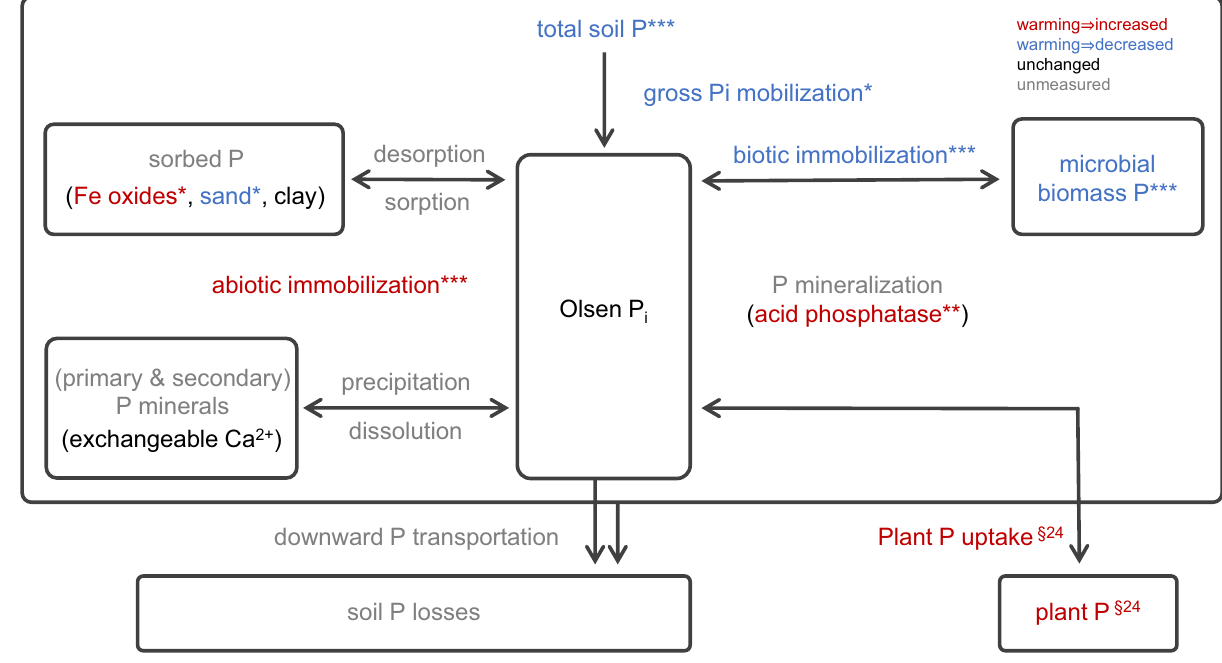
Fig.1|Schematicillustrationshowinglong-termwarmingeffectsonPpools,P processes, and geochemical parameters. Rectangular boxes represent P pools and arrows represent P processes. Red, blue, and black texts indicate long-term warming increased, decreased,and unchangedparameters, respectively.Grey text